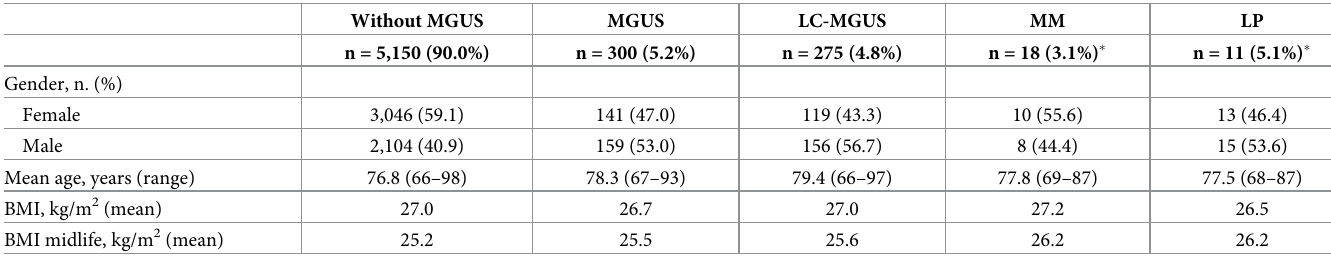
Table 1. Characteristics of study participants at AGES study entry. Without MGUS